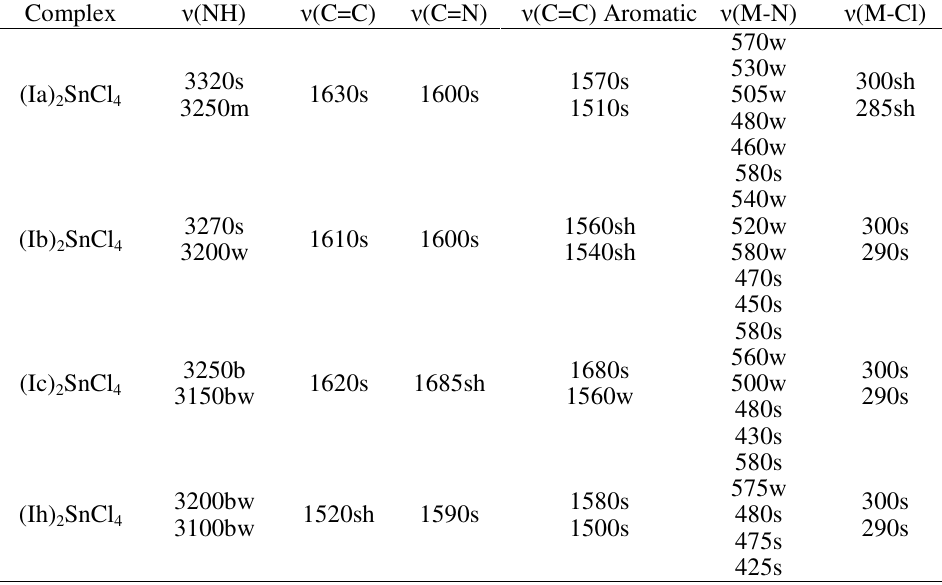
b = broad, s = sharp, m = medium, sh = shoulder, w =